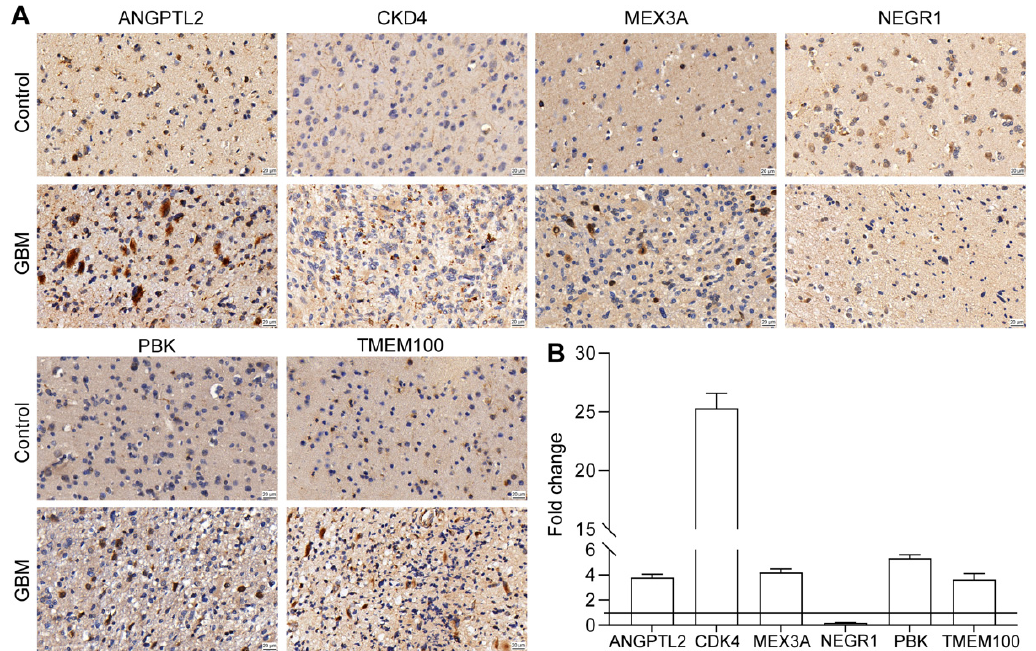
Figure 10. Validation of the expression of prognostic genes: ( A ) IHC images of the protein expres- sion of significant prognostic genes. Bronze area shows the expression of the detected protein (40× magnification, bar = 20 μ m); and ( B ) quantification of the activity of horseradish peroxidase. Fold change is the ratio of signal density between the control and GBM samples.